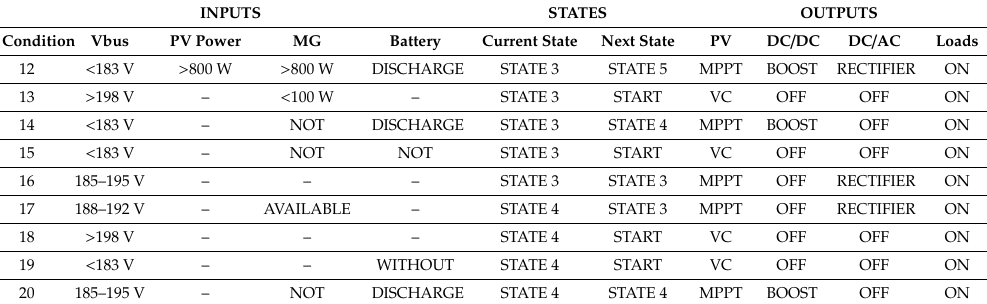
Table 5. GMC transitions in STATE 3 and 4.